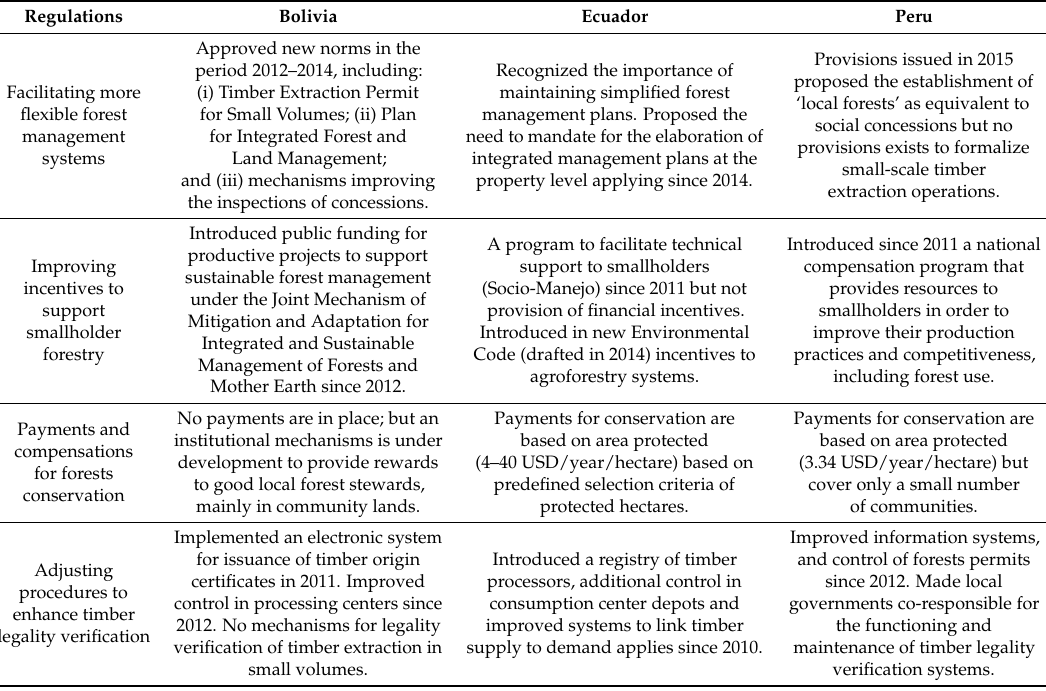
Table 3. Main New Forest Regulations in Bolivia, Ecuador and